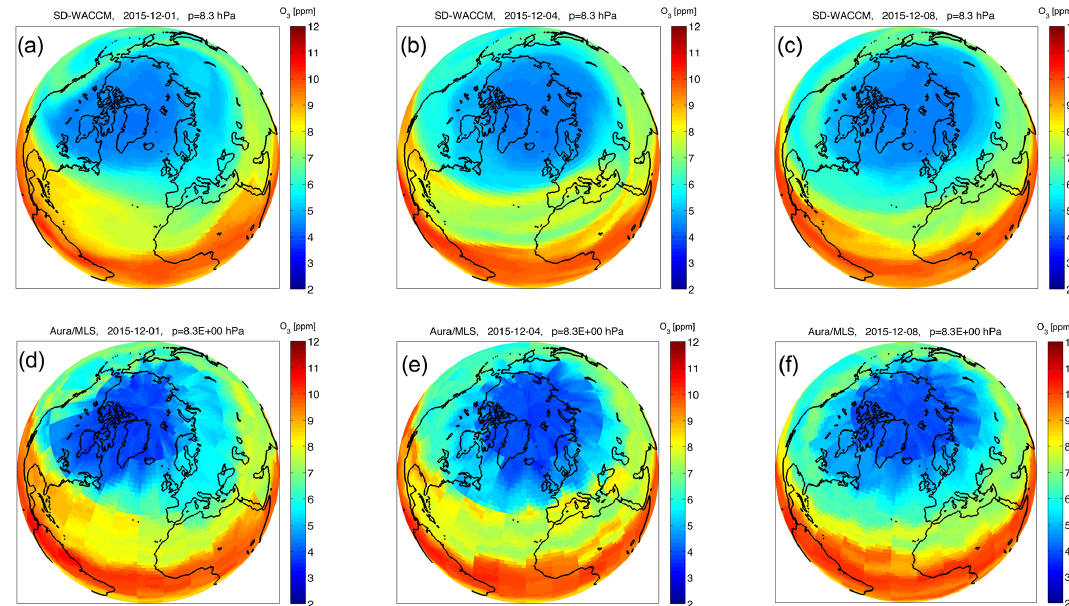
Figure 3. (a) Beginning of an ozone streamer extending from Mexico over the Atlantic to Morocco on 1 December 2015 at 8.3hPa (ca. 34km altitude) and simulated by SD-WACCM. (b) The ozone streamer narrows and extends to central Europe on 4 December 2015. (c) The ozone streamer is shifted southward and fades away on 8 December 2015. The graphs (d) , (e) and (f) are based on all valid ozone profiles of Aura/MLS measured during the days 1, 4 and 8 December